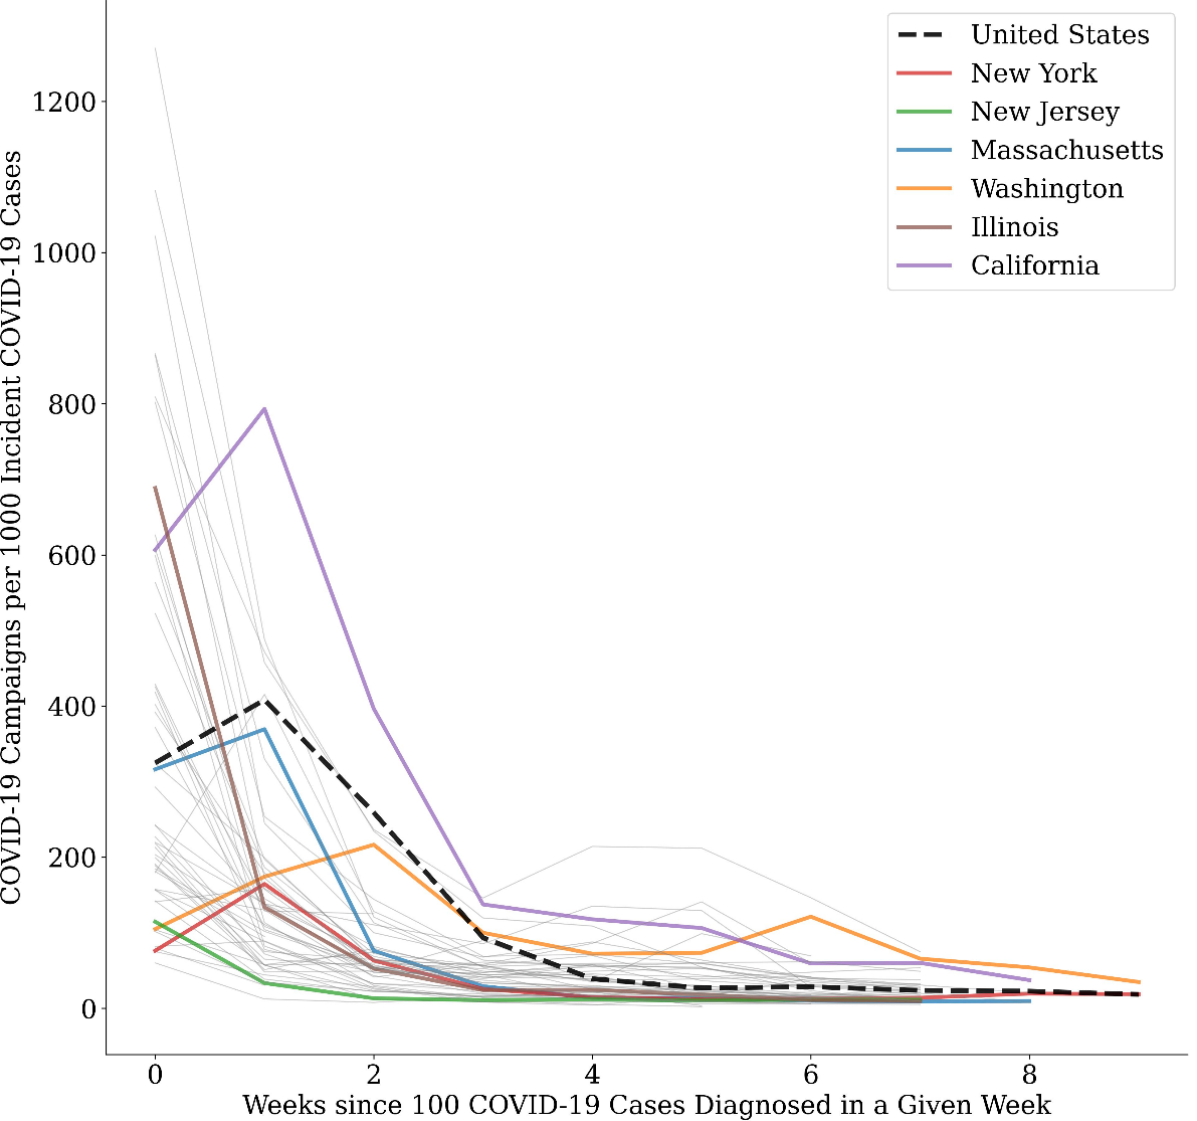
Figure 2. COVID-19–related GoFundMe campaigns per 1000 COVID-19 incident cases for each state. Week 0 is defined as the first week in which a state had more than 100 cases to enable direct comparison among states. All states are shown, but only the top 6 states for total COVID-19 cases per million are highlighted in color (ordered from most to fewest in the